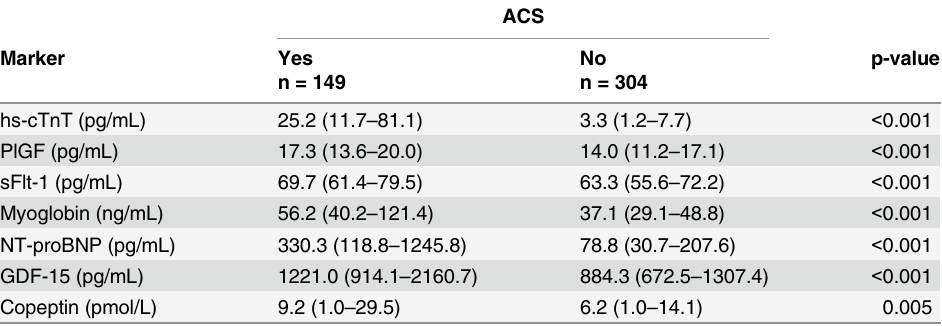
Table 2. Median biomarker concentrations and inter quartile ranges stratified by ACS status.